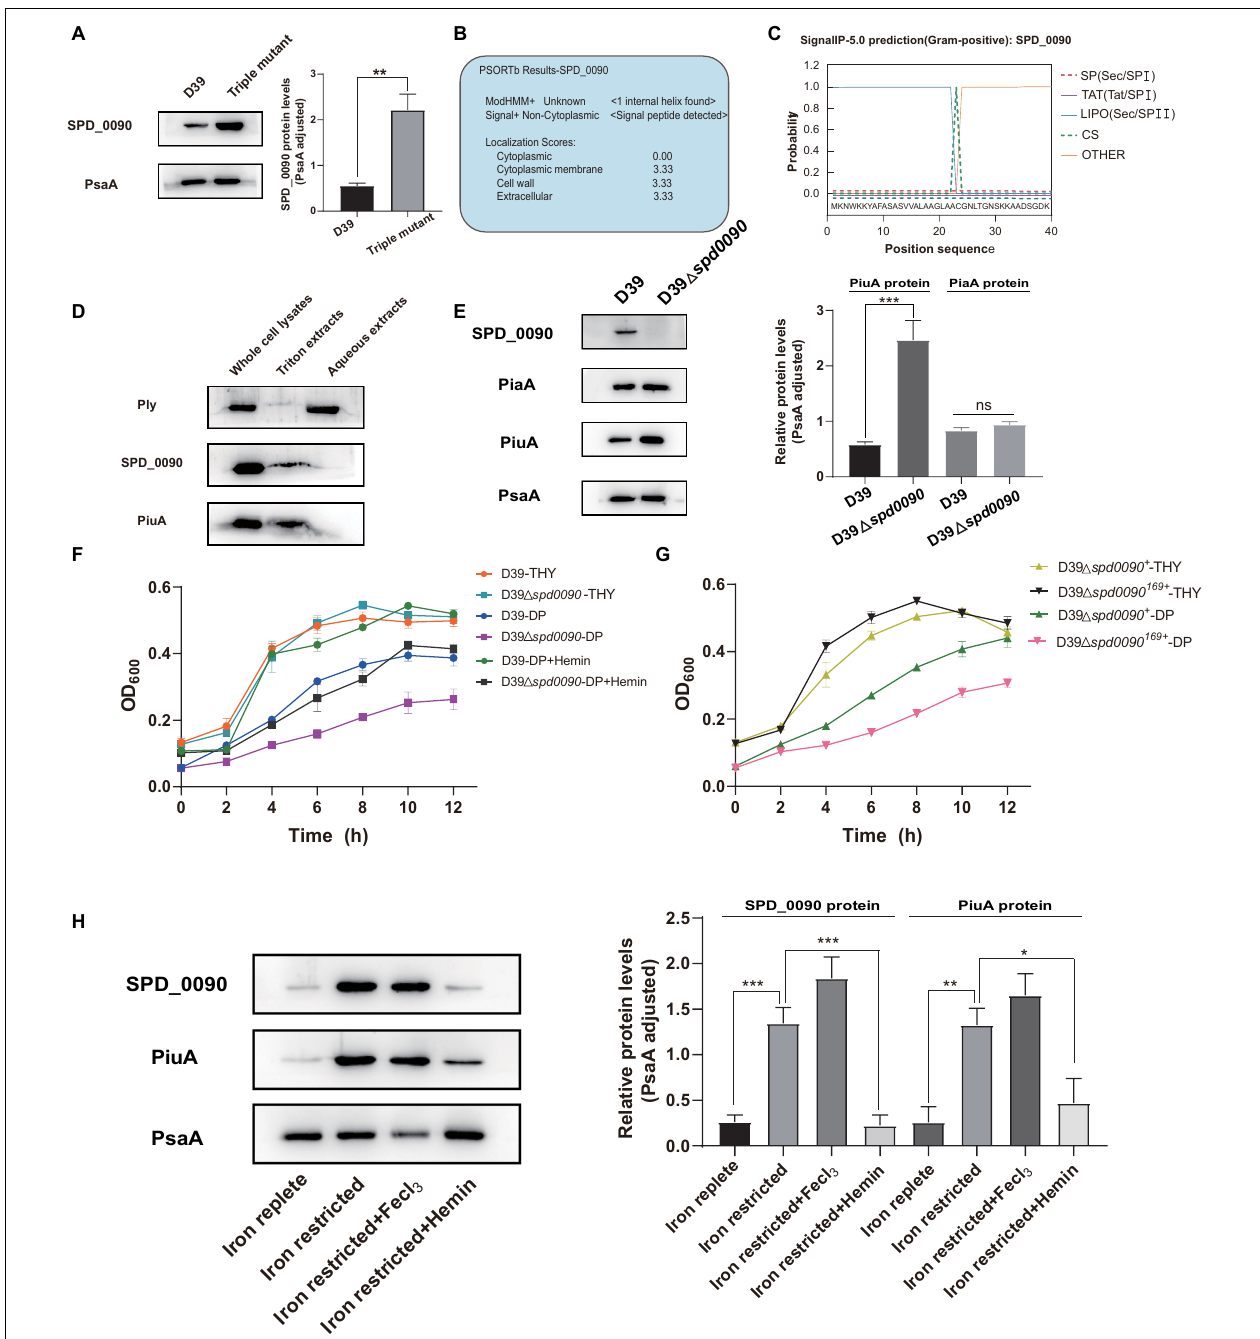
FIGURE 4 | The deletion of the spd _ 0090 gene affects the ability of S. pneumoniae to use hemin. (A) Western blot analysis of the protein levels of SPD_0090 in D39 and Triple Mutant strains (D39 (cid:49) piaA (cid:49) piuA (cid:49) pitA ). (B) The PSORTb analysis of SPD_0090 protein. (C) The SignaIP 5.0 analysis of SPD_0090 protein. (D) Western blot analysis of SPD_0090 as a membrane protein. The protein of SPD_0090, PiuA, and Ply in whole cell lysates, Triton X-114 isolated membrane protein phase and aqueous phase was determined by Western blot. (E) The protein levels of PiaA and PiuA in THY-extracted D39 and D39 (cid:49) spd0090 whole-cell lysates determined by Western blot. (F) Growth curves of the D39 and D39 (cid:49) spd0090 strains in iron-replete, iron-restricted, and iron-restricted supplement 25- µ M hemin. Data are presented as the mean ± SEM from three independent growth curves. (G) Growth curves of the D39 (cid:49) spd0090 169 + and D39 (cid:49) spd0090 + strains under iron-replete (THY) and iron-restricted conditions (1 mM 2, 2 (cid:48) -dipyridyl, DP). (H) SPD_0090 and PiuA protein levels in whole proteins extracted from D39 cultured in iron-replete, iron-restricted, iron-restricted + FeCl 3 , and iron-restricted + hemin media. PiuA served as a positive control. The figure of Western blot is representative of at least three independent replicates. Western blot data were quantified using ImageJ, normalized by PsaA and analyzed by GraphPad Prism version 8.0.2. Data were analyzed by two-tailed, unpaired Student’s t -tests, and results are expressed as means ± SD. *** p < 0.001, ** p < 0.01, * p < 0.05. ns, no significance.